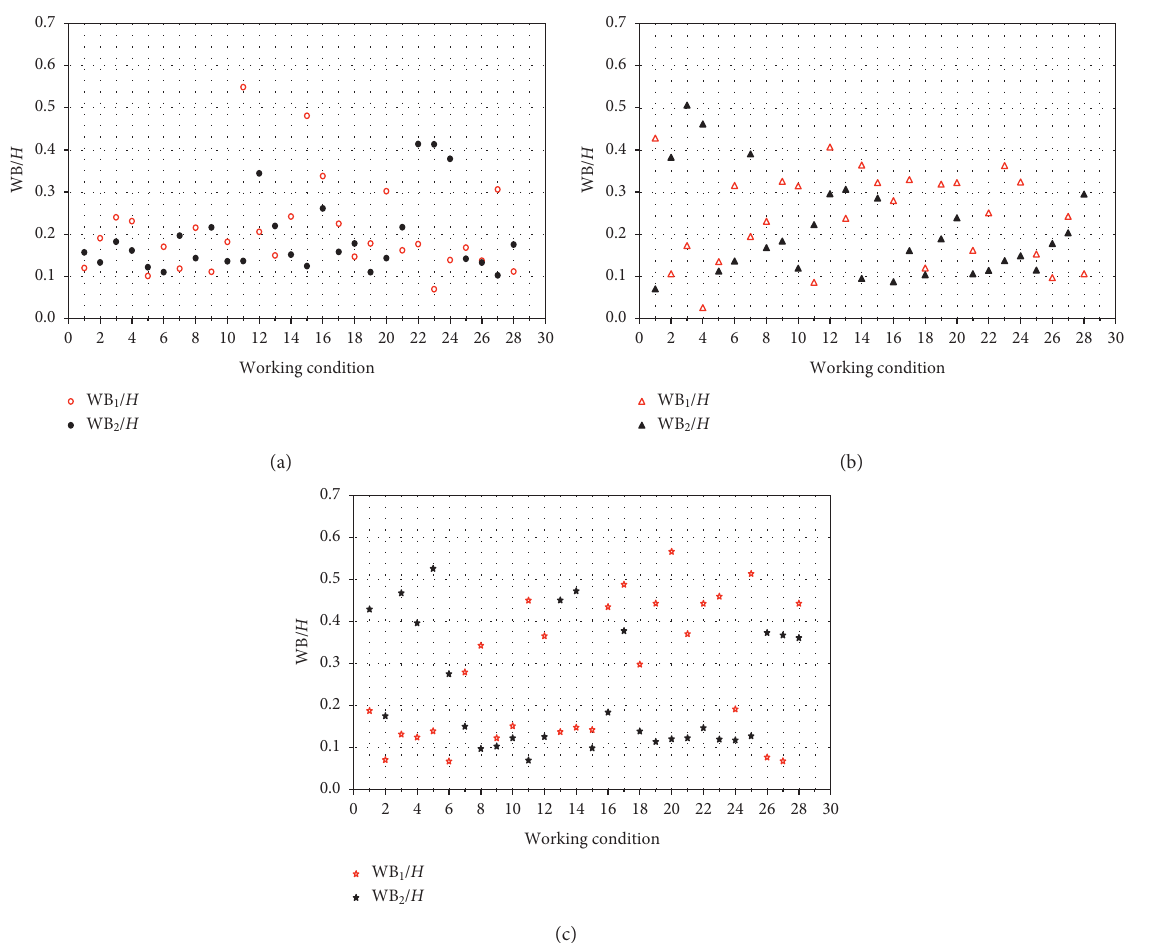
Figure 11: Width coefficient of influence along the Z axis of continuous collapse of masonry structure under various working conditions. (a) The three-story masonry structure along the Z axis, (b) the five-story masonry structure along the Z axis, and (c) the seven-story masonry structure along the Z